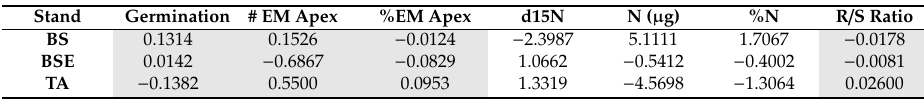
Table 3. Random e ff ects attributed to stands extracted from di ff erent GLMM and LMM (full model estimates reported in Tables 1 and 2, Table S3). In grey, the variance attributed to stands was larger to variance attributed to